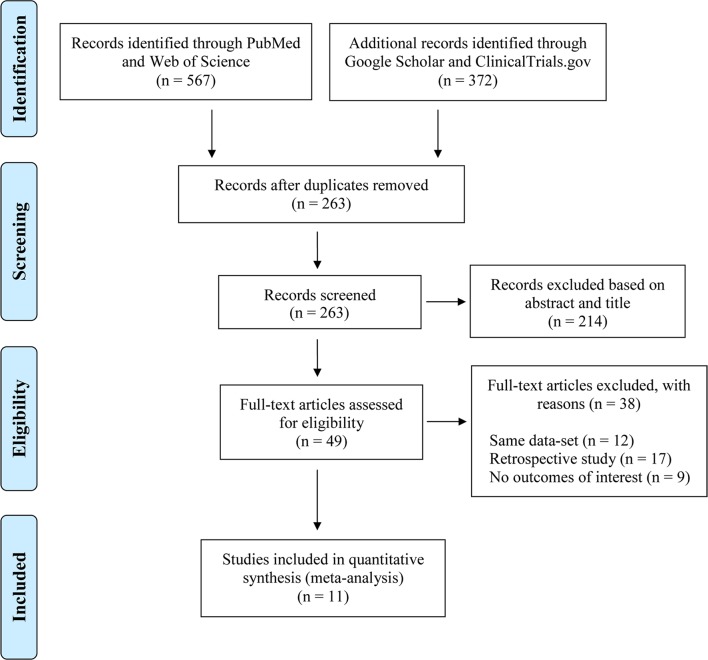
Flow chart of included studies.